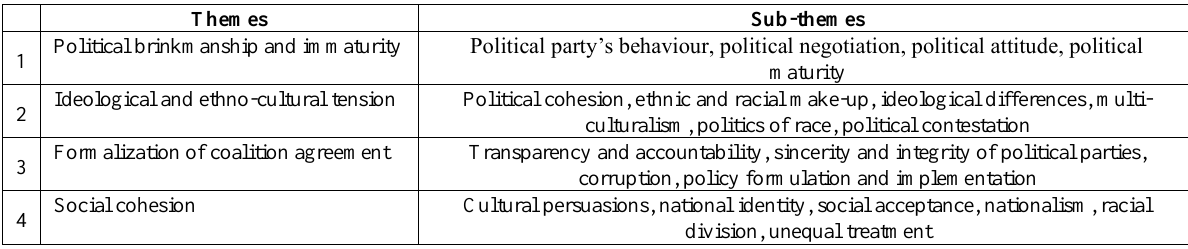
Table 2. Themes and